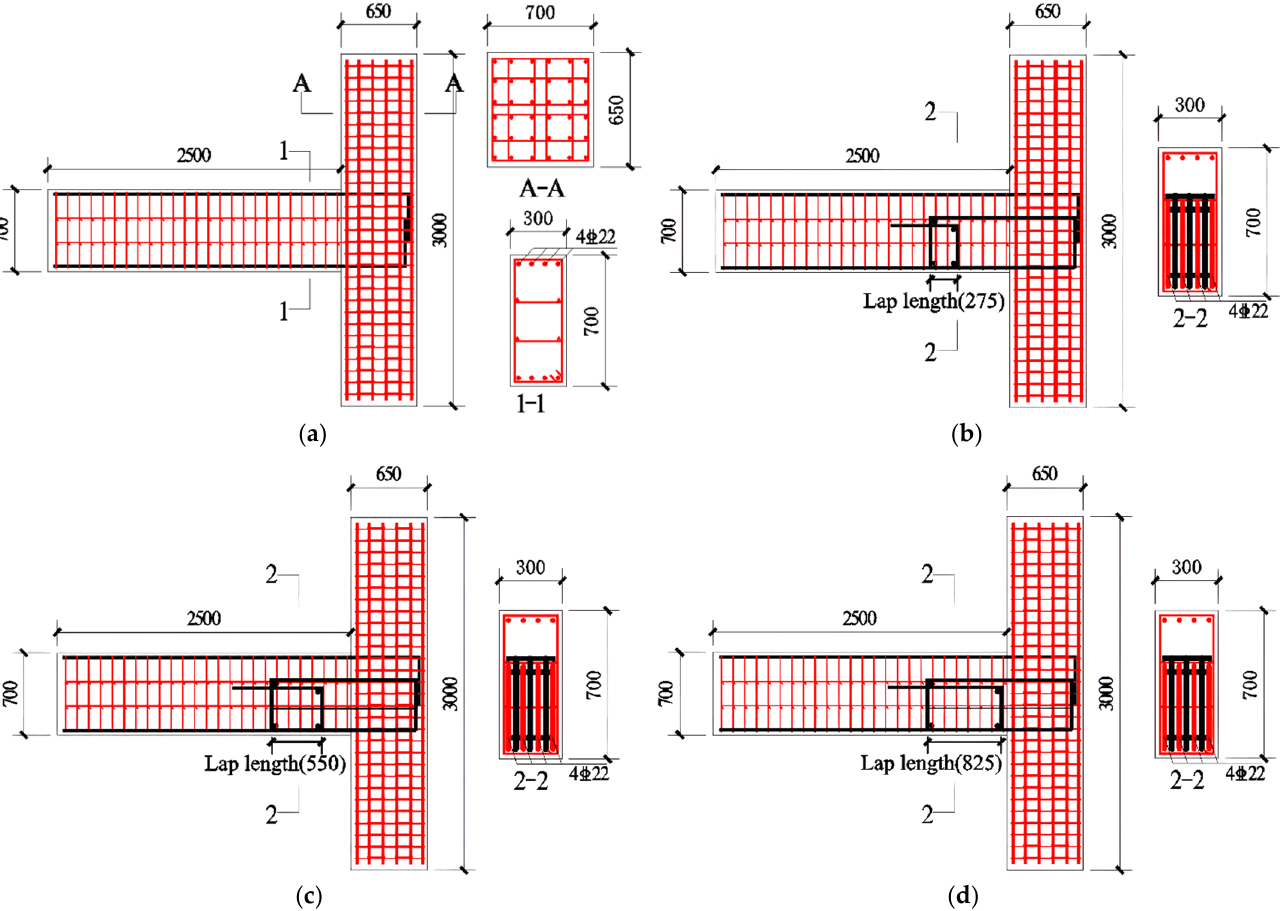
Figure 5. Constructional form of the specimen: ( a ) Specimen XJ-1; ( b ) Specimen UX-1; ( c ) Specimen UX-2; ( d ) Specimen UX-3. Table 1. Specimen design parameters.